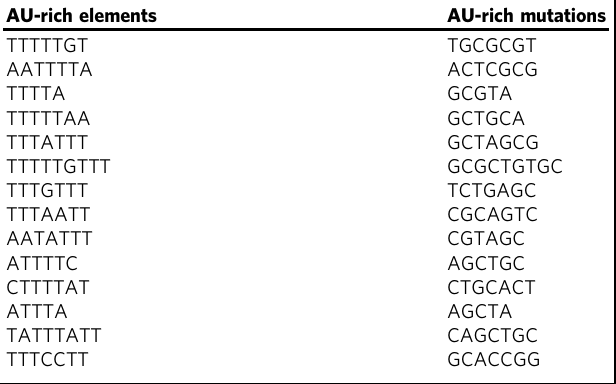
Table 1 AU-rich elements identi fi ed in the MAARS transcript and the respective mutations in the AREmut biotinylated MAARS transcript used for RNA pulldown in Fig. 4d – f. AU-rich